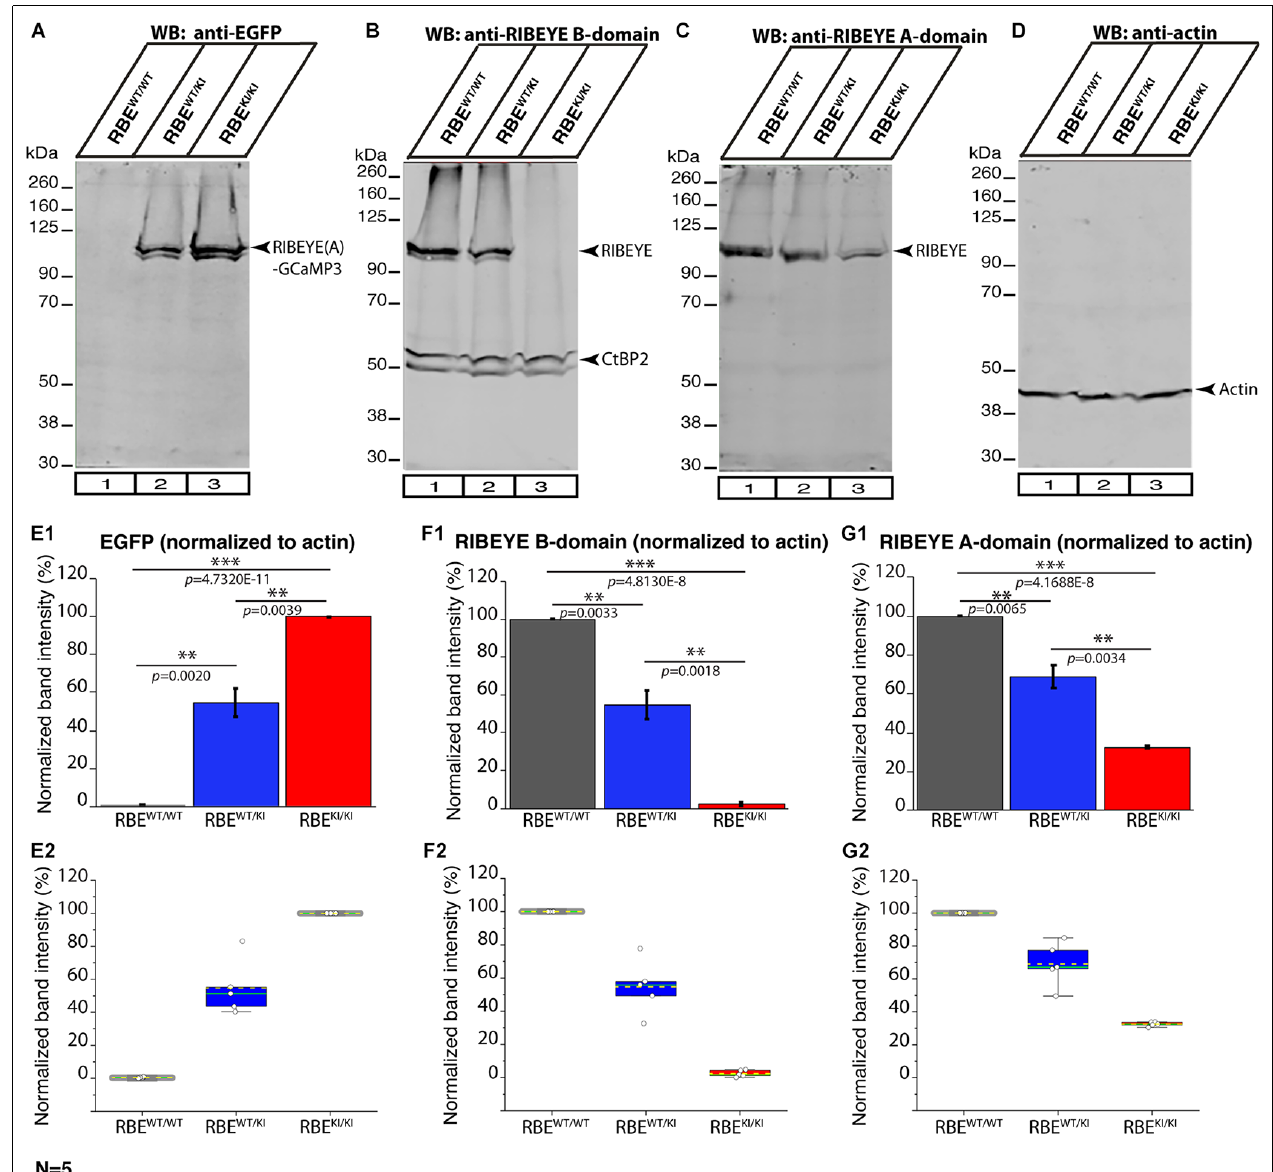
FIGURE 12 | RIBEYE expression in the retina of RBE WT/WT , RBE WT/KI , and RBE KI/KI mice (WB analyses; Li-Cor system). Retinal lysate from RBE WT/WT , RBE WT/KI , and RBE KI/KI mice were probed by Western blot (WB) analyses with anti-GFP (A) , anti-RIBEYE B-domain (B) , anti-RIBEYE A-domain (C) , and anti-actin (D) . Anti-actin signals were used as loading control and for the normalization of GFP, RIBEYE B-domain, and RIBEYE A-domain WB bands. (E1–G2) Quantification of the indicated WB band intensities in RBE WT/WT , RBE WT/KI , and RBE KI/KI mice using the Li-Cor system. The total fluorescent intensity values of the WB bands were computed using Image Studio Lite software and normalized to the loading control (actin). For the anti-GFP Western blots the RBE KI/KI values, and for the anti-RIBEYE B-domain/RIBEYE A-domain Western blots the RBE WT/WT values were set to 100% to better evaluate the relative changes in the different genotypes. Values in (E1,F1,G1) are means ± S.E.M. In the box and whisker plots (E2,F2,G2) of the data from (E1,F1,G1) , mean values are indicated by dotted horizontal lines; median values by solid horizontal lines. Boxes represent 25th-75th percentiles of data points; whiskers are equal to 1.5 times of the interquartile range (IQR). The expression of CtBP2 at ≈ 55 kDa did not differ significantly between the three analyzed genotypes RBE WT/WT vs. RBE WT/KI : p = 0.9427; RBE WT/KI vs. RBE KI/KI : p = 0.8108; RBE WT/WT vs. RBE KI/KI : p = 0.6842. To determine the statistical significance, Student’s t -test was performed. Abbreviations: RBE, RIBEYE; S.E.M., standard error of the mean; N = number of the littermate mouse “triples” of the respective genotypes (RBE WT/WT , RBE WT/KI and RBE KI/KI ); ∗∗ p ≤ 0.01; ∗∗∗ p ≤ 0.001.